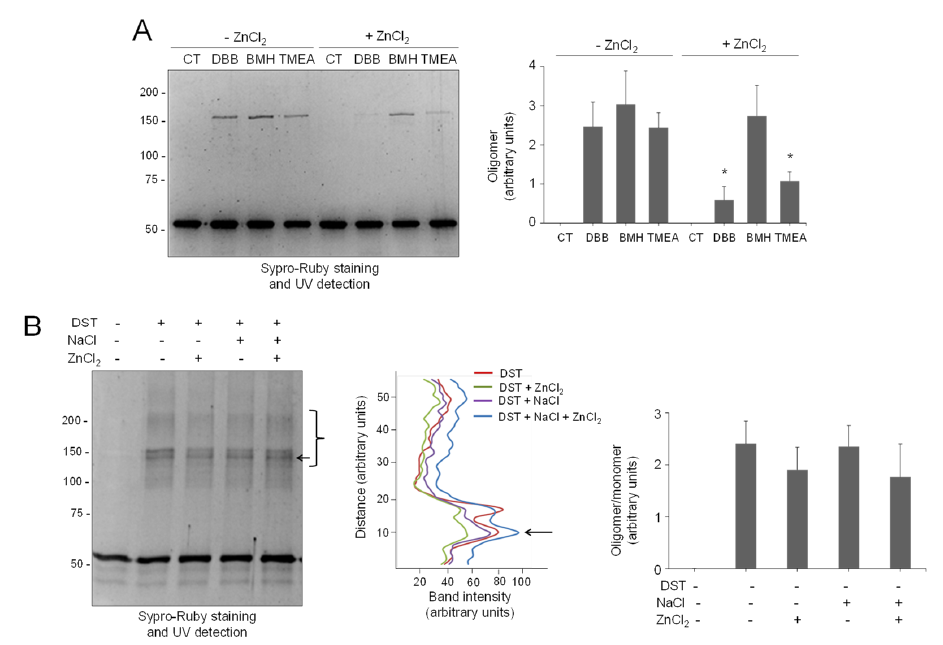
Figure 6. Selectivity of the protective effect of zinc on vimentin crosslinking. ( A ) Vimentin wt (4.3 μ M final concentration) was incubated with vehicle or 500 μ M ZnCl 2 for 1 h at r.t., before the addition of the vehicle (DMSO) or the indicated cysteine crosslinkers at 24 μ M for incubation during 1 h more. Incubation mixtures were analyzed by SDS-PAGE and Sypro Ruby staining. Oligomeric species were estimated by image scanning, and mean values ± SEM from three assays are represented in the graphs. * p < 0.05, with respect to the reaction with the same crosslinker in the absence of ZnCl 2 by paired Student’s t-test. ( B ) Effect of zinc on vimentin crosslinking by an amine-reactive compound. Left panel, vimentin wt (5.8 μ M final concentration), was incubated with vehicle, 150 mM NaCl, or 500 μ M ZnCl 2 for 1 h at r.t. Incubation mixtures were then treated with the amine-reactive crosslinker disuccinimidyl tartrate (DST) at 400 μ M for 1 h at 37 °C and analyzed as in ( A ). Middle panel, the intensity of the oligomeric species in the region delimited by the bracket was estimated and is depicted in the graph as a function of the distance (from bottom to top of the marked region). The arrow pointing to the most intense band is shown for reference. Right panel, the ratio of oligomeric (bracket) versus monomeric species was estimated and is depicted in the graph as mean values ± SEM from three assays. No significant differences were found by paired Student’s t -test.